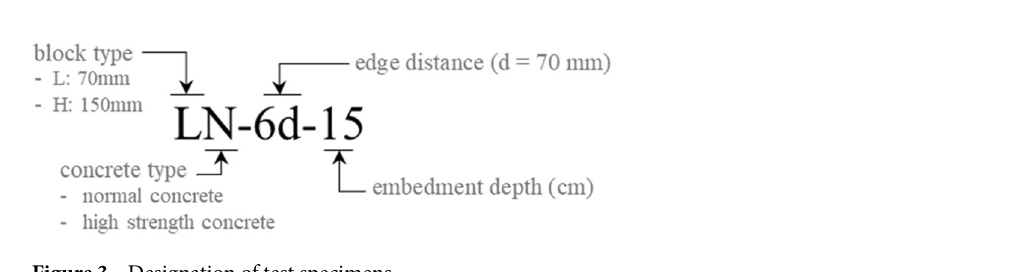
Figure 3. Designation of test